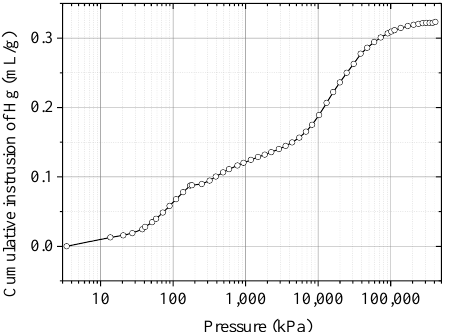
Figure 7. Curve of Cumulative volume of Hg with pressure.